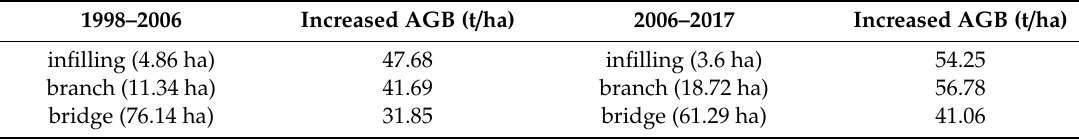
Table 9. Quantitative analysis between landscape structure and ecological